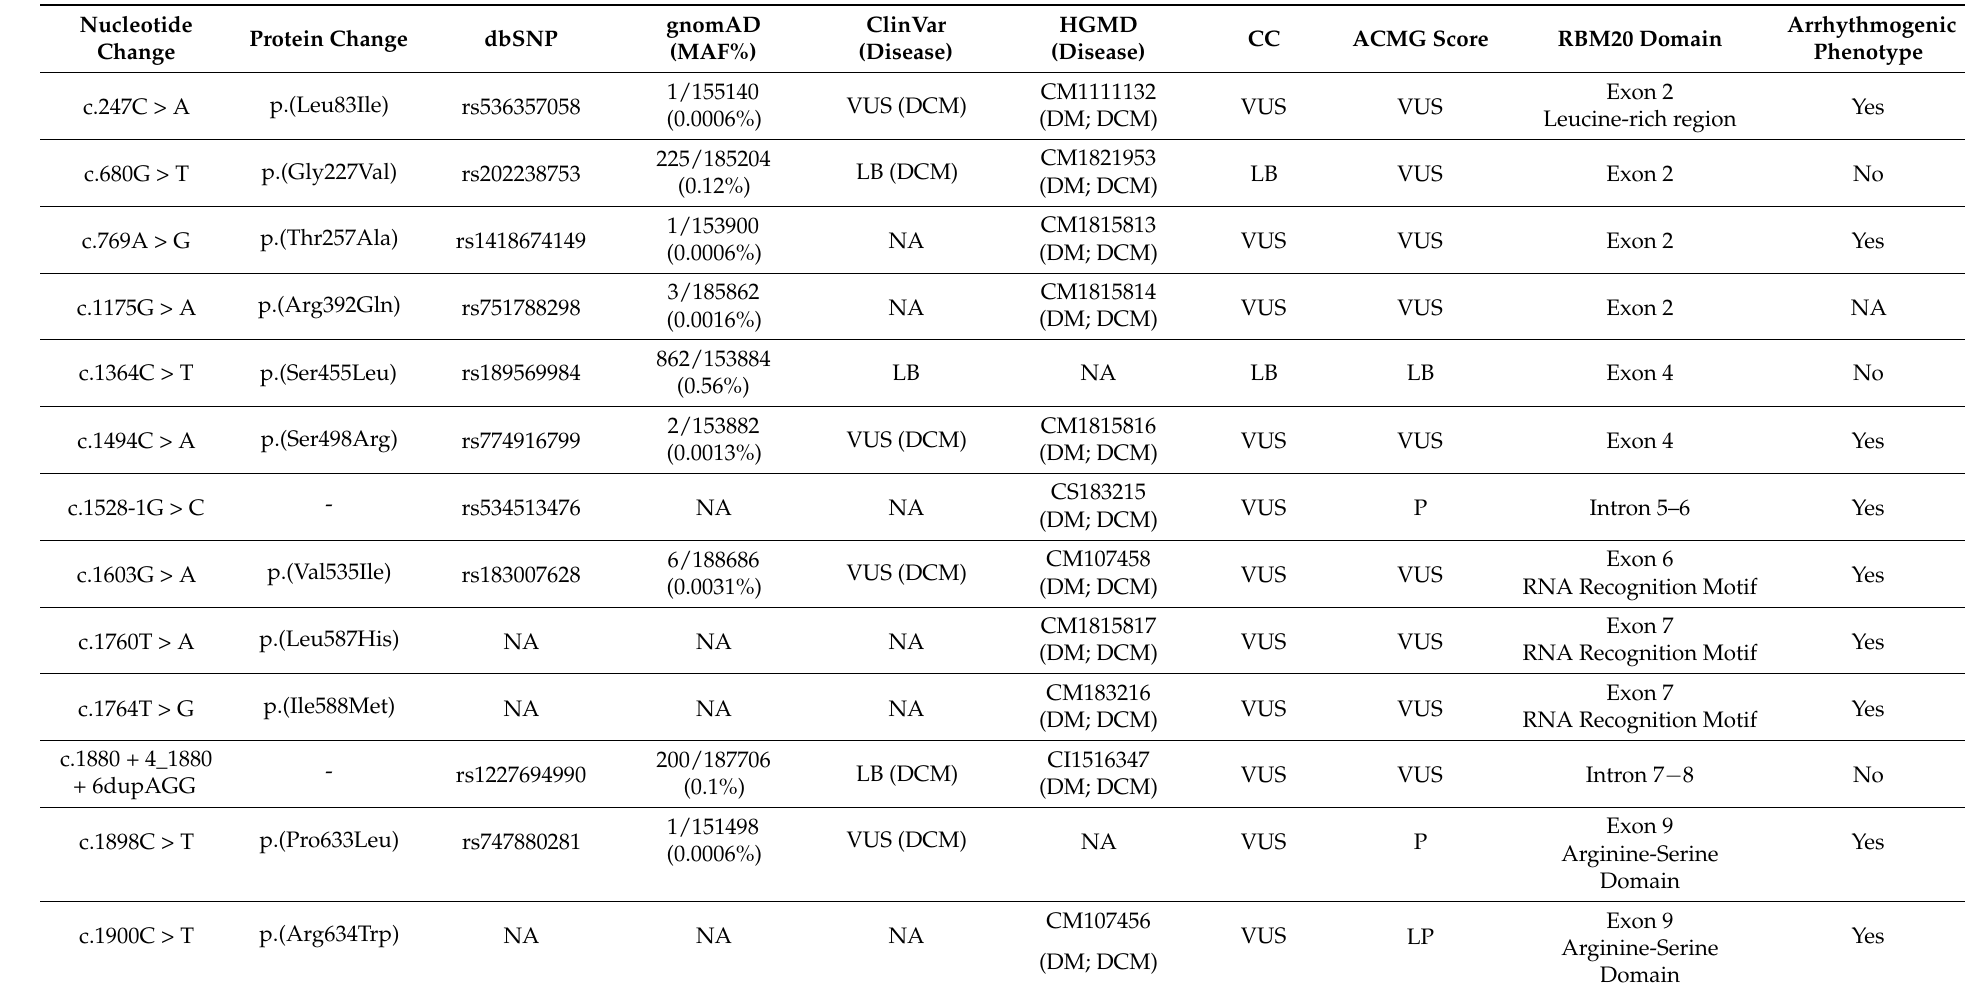
Table 1. Data of variants in RBM20 potentially associated with Dilated